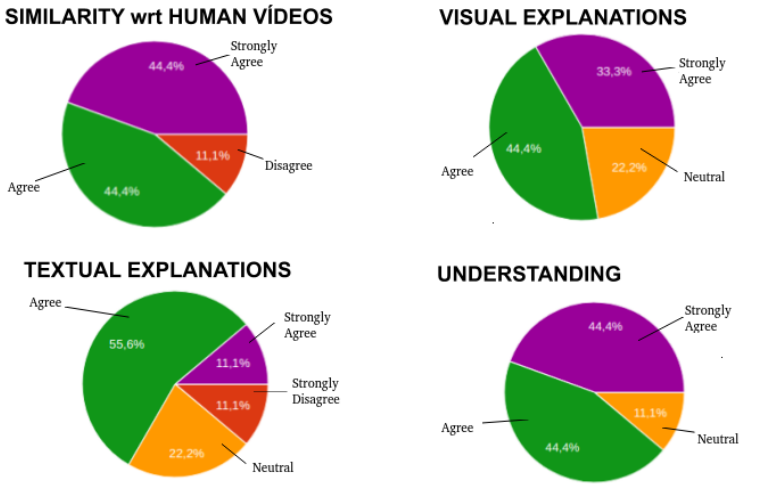
Figure 11. Percentages obtained from the answers of the experts for the questions about similarity regarding human, visual/textual explanations and